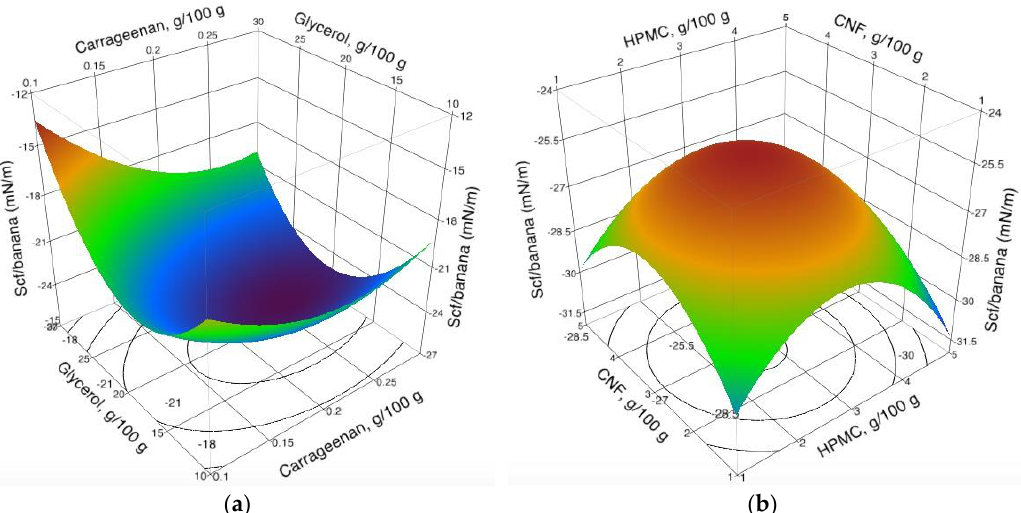
Figure 2. Response surface of S cf/banana as a function of ( a ) κ-carrageenan and glycerol, ( b ) HPMC and cellulose nanofibers (CNF).